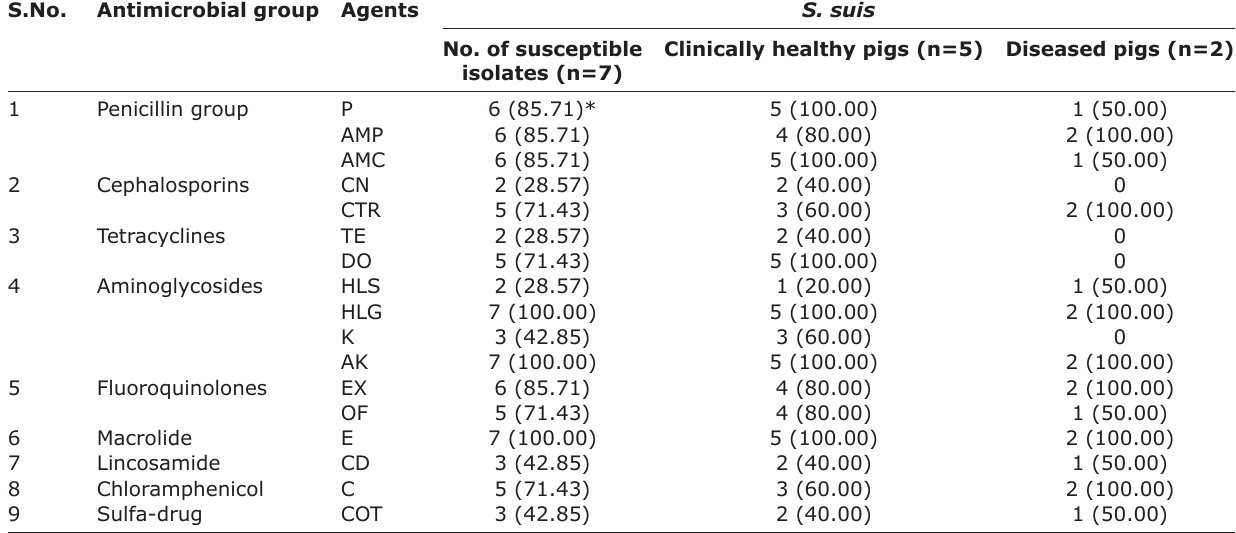
Table-2: Antimicrobial susceptibility of S. suis .